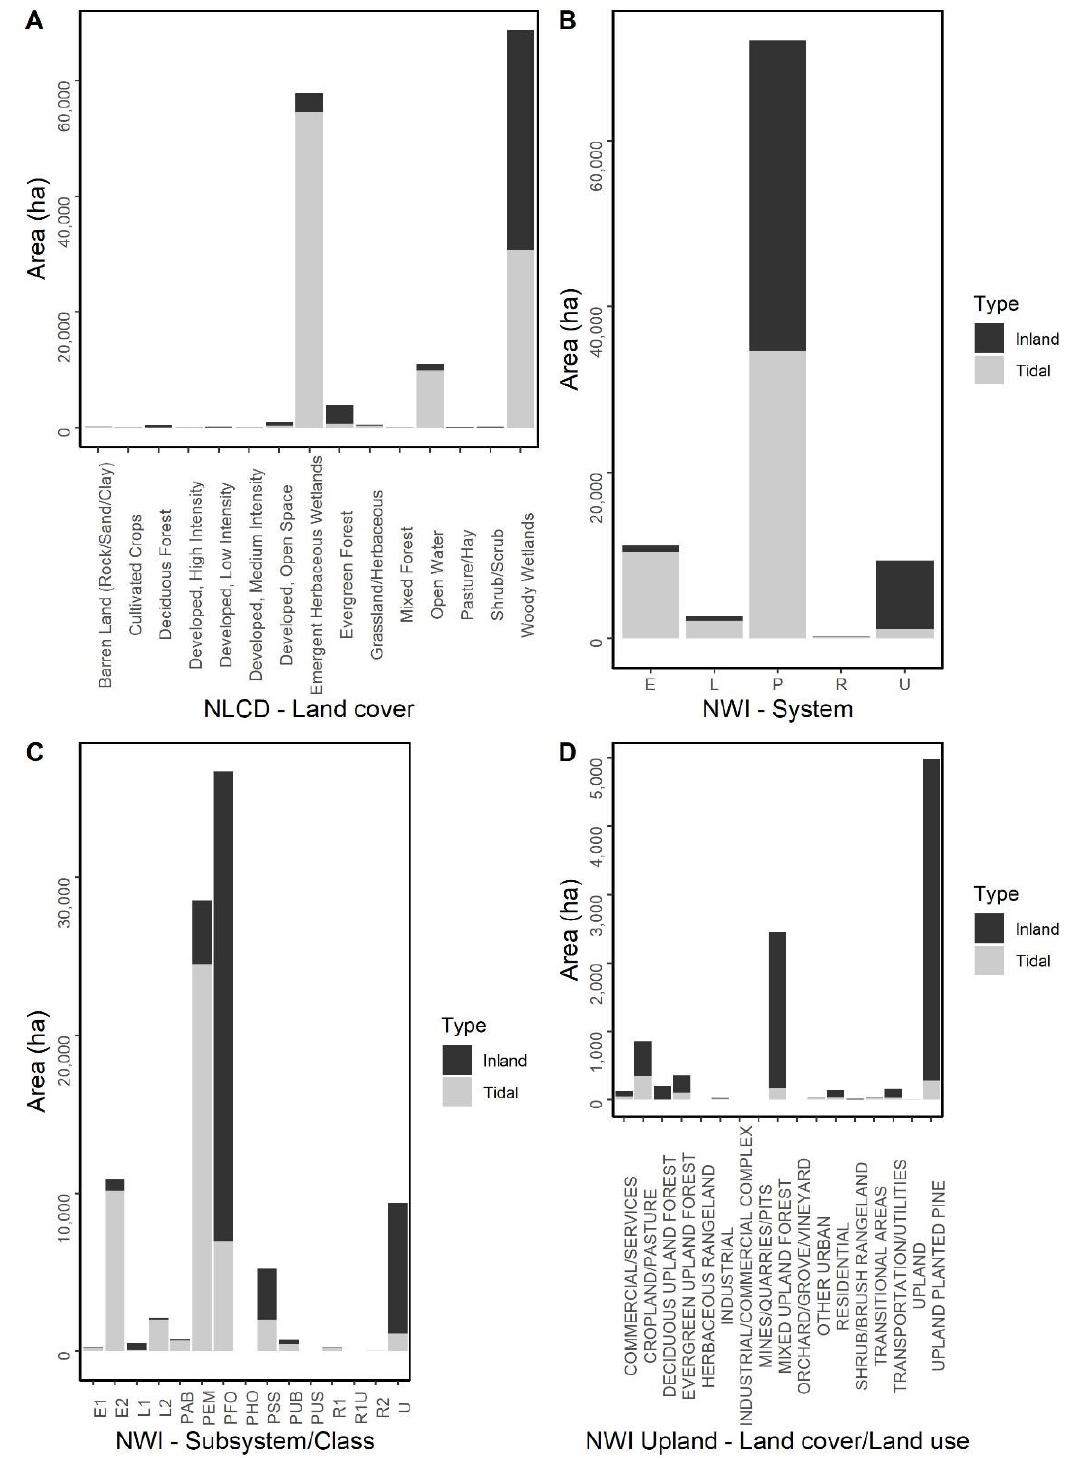
Figure 5. Area in hectares is given for where historic rice fields are geographically coincident with the National Land Cover Dataset (NLCD) and the National Wetlands Inventory (NWI). NLCD land cover types ( A ), NWI System type ( B ), NWI Subsystem/Class type ( C ), and NWI Upland Land Cover/Land Use ( D ). ( B ) National Wetland Inventory System type: E—Estuarine, L—Lacustrine, P—Palustrine, R—Riverine, and U—Upland. ( C ) National Wetlands Inventory Subsystem/Class type: E1—Estuarine Subtidal, E2—Estuarine Intertidal, L1—Lacustrine Limnetic, L2—Lacustrine Littoral, PAB—Palustrine Aquatic Bed, PEM—Palustrine Emergent, PFO—Palustrine Forested, PSS—Palustrine Scrub–Shrub, PUB—Palustrine Unconsolidated Bottom, R1—Riverine Tidal, R2—Riverine Lower Perennial, and